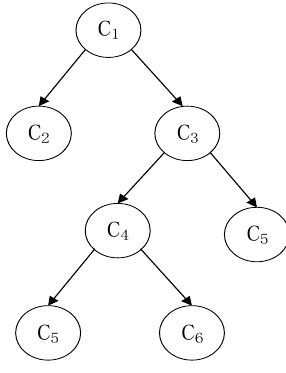
Figure 2. The decision tree model.